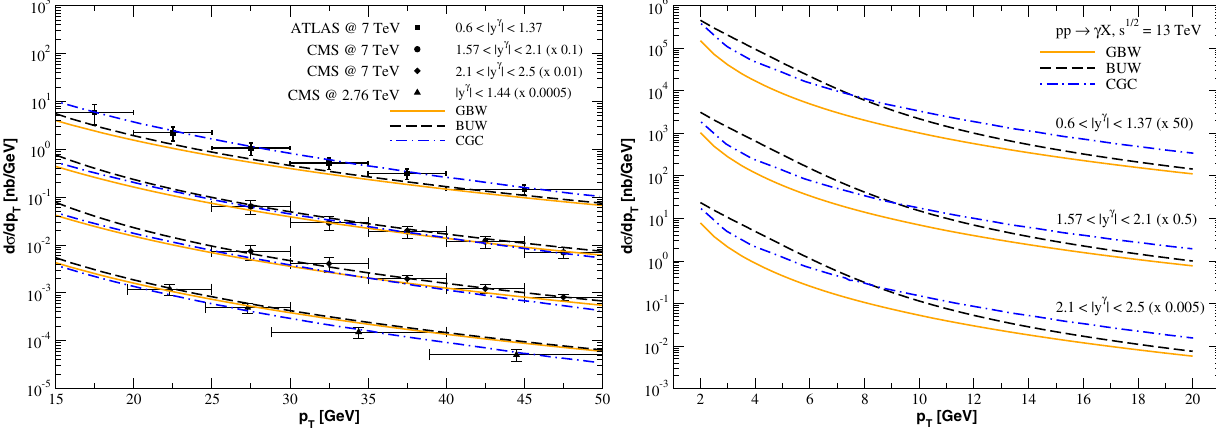
Fig. 4 Predictions of the CD models in four different rapidity ranges at a low- p T region (left) compared to the data collected at 2.76 TeV (CMS) and 7 TeV (CMS and ATLAS). In view of future data-takings, the predictions at 13 TeV are shown for a lower p T range (right) in three rapidity